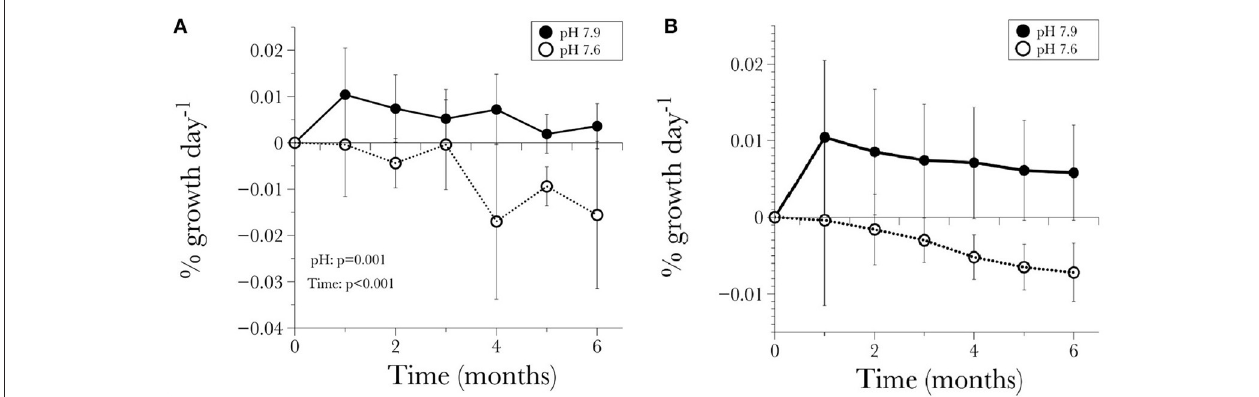
FIGURE 2 | (A) Long-term time-series of the calcification response of L. pertusa standardized by the initial weight for each time point, (B) calcification response standardized by initial weight t 0 at the beginning of the experiment. Values are given as mean ± S.D .